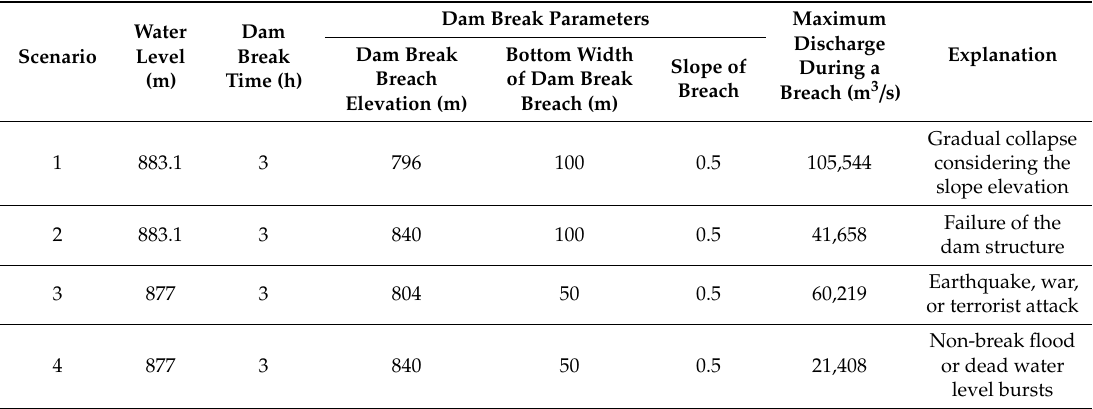
Figure 1. Simulation area. Table 1. Dam break parameters of each